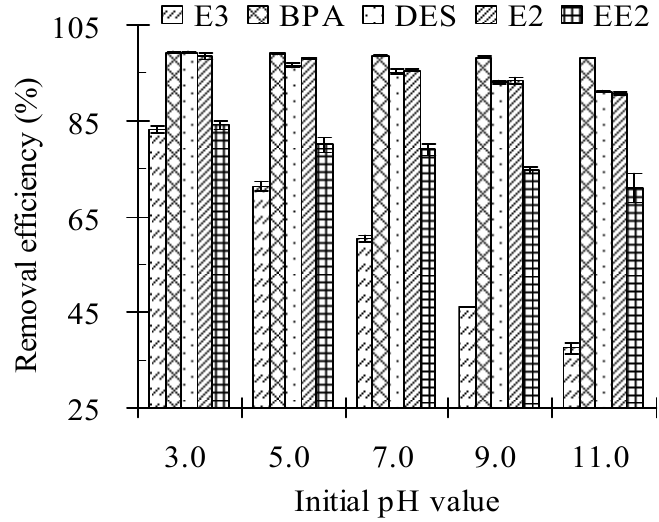
Figure 4. Effect of initial pH values on the removal efficiency of estrogens from cow manure by the Fenton oxidation process. Note: Fe(II) to H 2 O 2 molar ratio = 0.10 M/M; H 2 O 2 dosage = 2.56 mmol/g; solid to water mass ratio = 2 g/mL; reaction time = 24 h. Error bars are standard deviations.